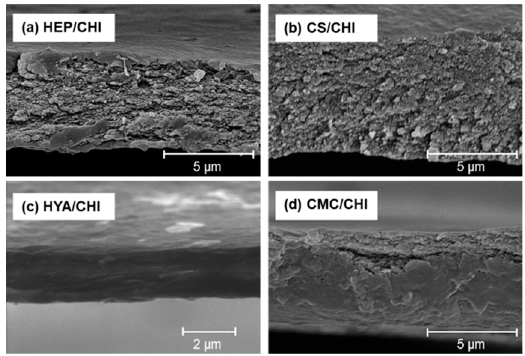
Figure 3. Scanning electron microscopic (SEM) images of polysaccharide composite films composed of HEP/CHI ( a ), CS/CHI ( b ), HYA/CHI ( c ), and CMC/CHI ( d ).